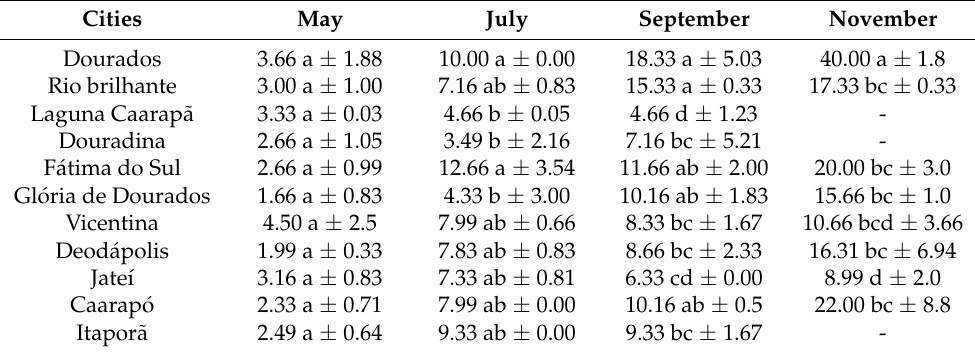
Table 3. Micronuclei Frequency (MCN) observed in Tradescantia pallida cells in eleven cities of the Grande Dourados Microregion in four collection